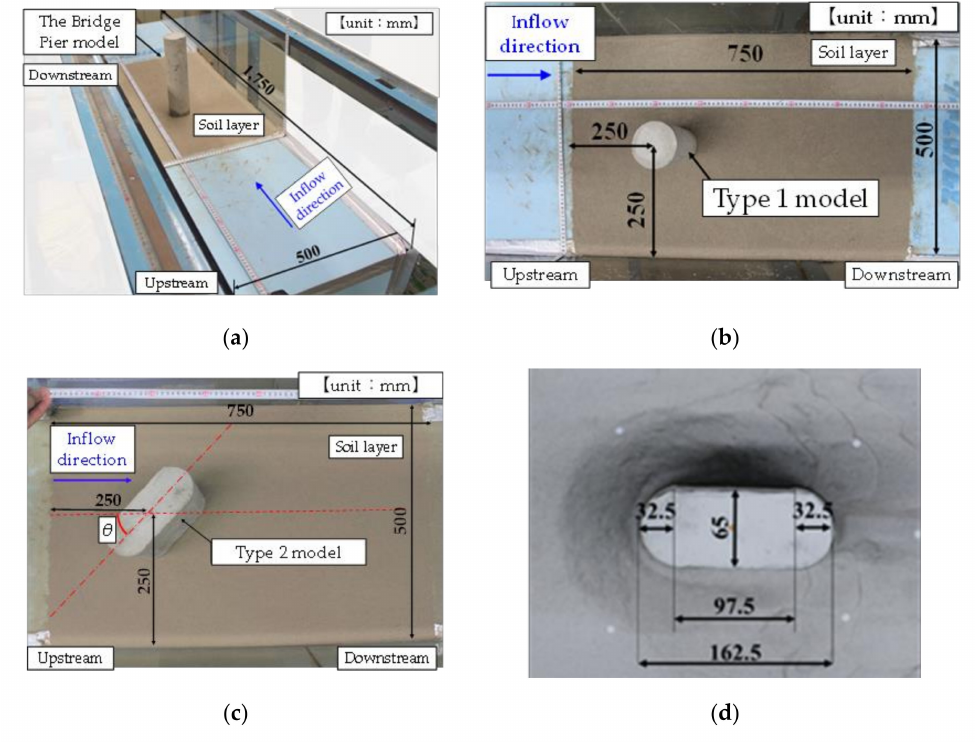
Figure 1. Experiment setup: ( a ) Entire open channel; ( b ) Detailed view of the soil layer using a Type 1 model; ( c ) Detailed view of the soil layer using a Type 2 model. The specimen is rotated by θ with respect to the river flow center; and ( d ) Dimensions of Type